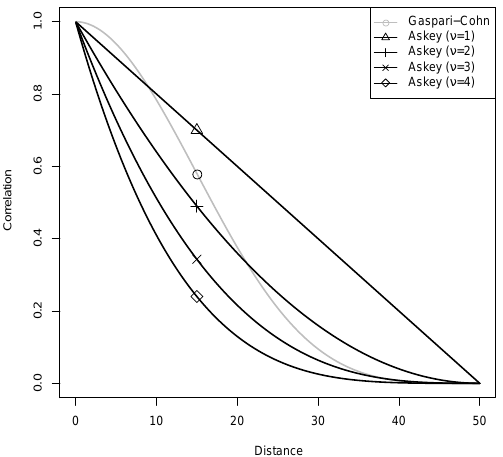
Figure 1. The Gaspari–Cohn covariance function with a localiza- tion constant c = 25 (support of 50) and the Askey covariance func- ) ν + , with a support parameter c = 50 and tion f (d ; ν , c) = ( 1 − d c various shape